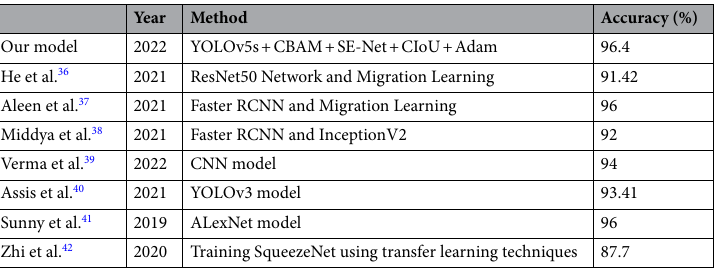
Table 14. Comparison of our developed model with other garbage detection methods in the